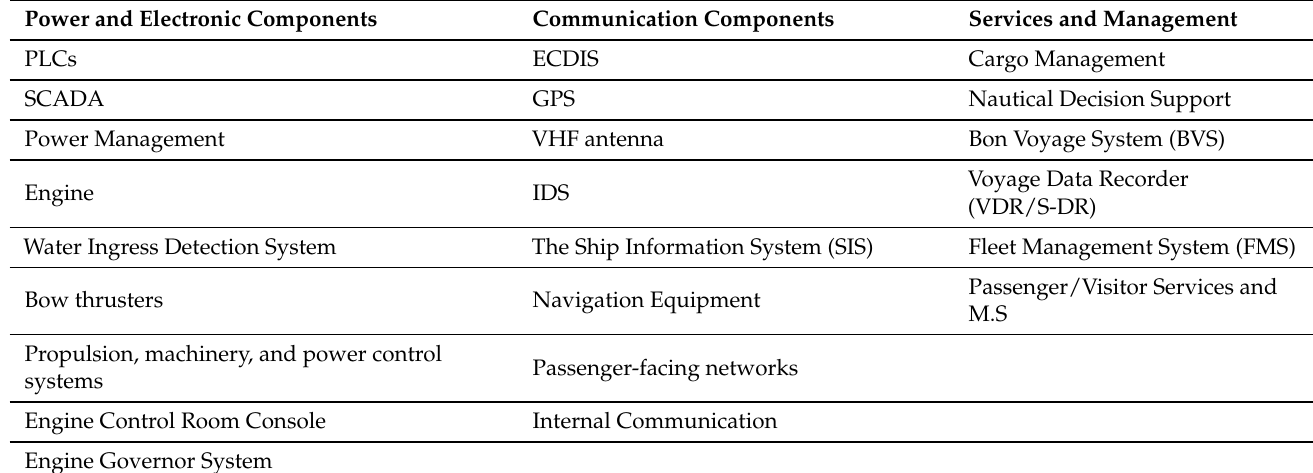
Table 3. On-vessel components